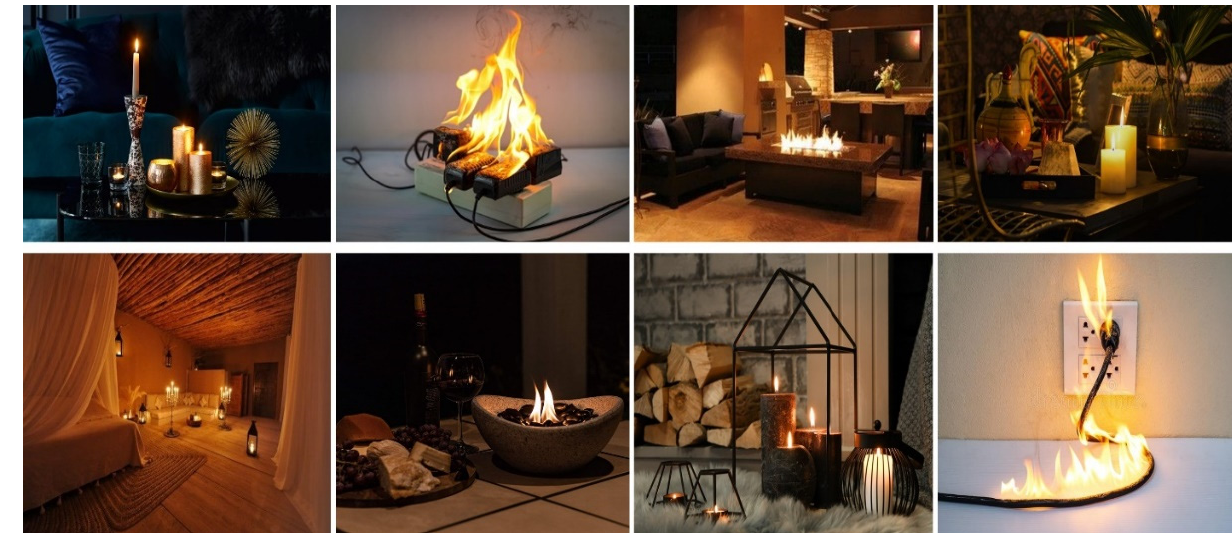
Figure 8. Examples of small fire images for indoor fire detection dataset.